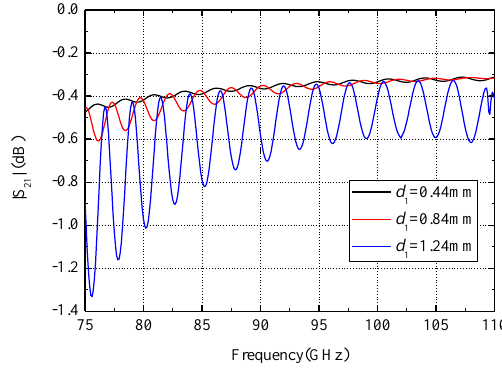
Figure 8. Transition performance given by different values of d 1 .